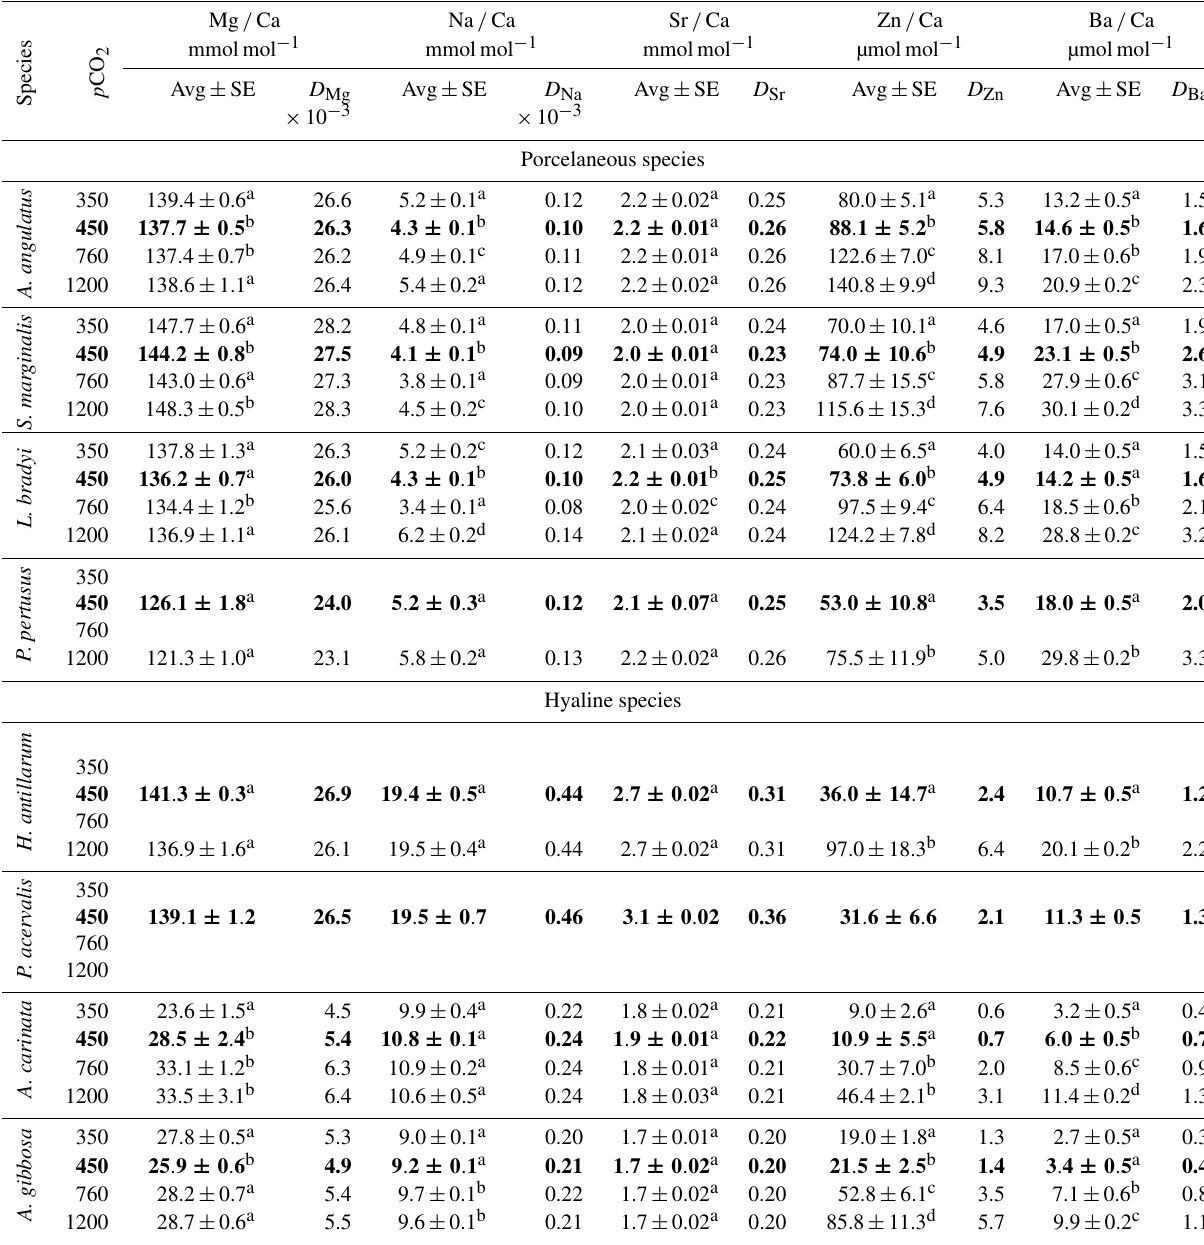
Table 3. Overview of element to Ca ratios in foraminiferal calcite (Avg, average; SE, standard error) and partition coefficients D E , with D E of ambient conditions (treatment B) in